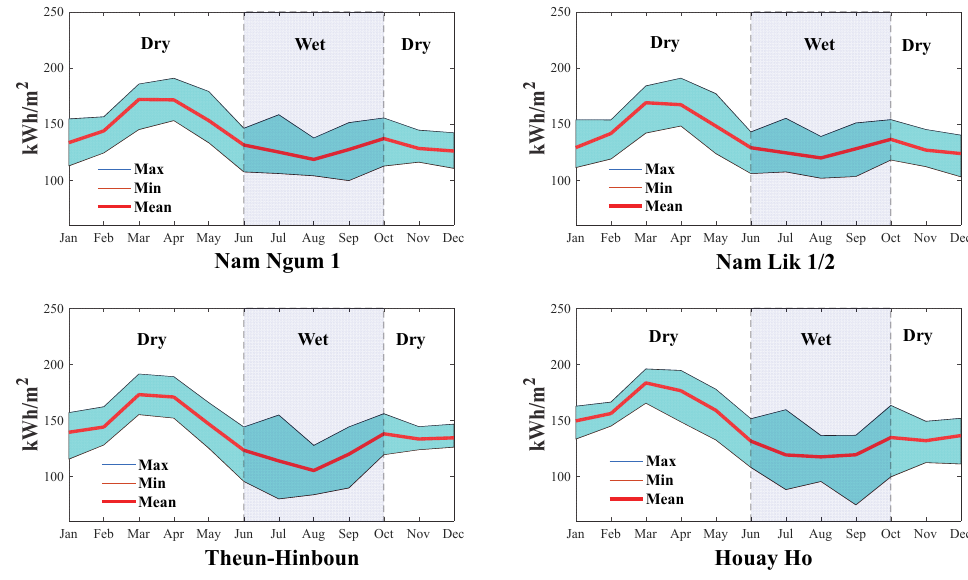
Figure 4. Monthly mean global horizontal irradiance from 2005 to 2020 of the four existing hydropower reservoirs in Laos.